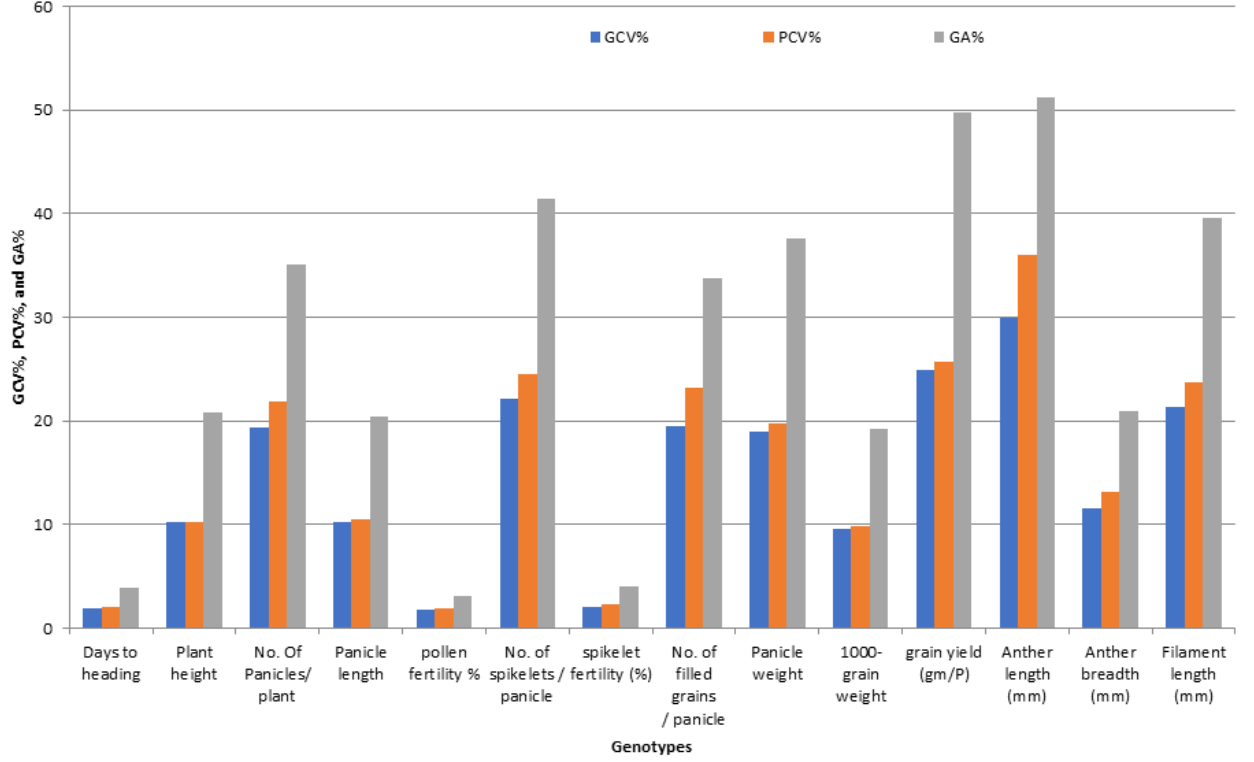
Figure 2. The percentage of variability parameters for floral traits, grain yield, and their contributing traits in promising restorer lines of rice.